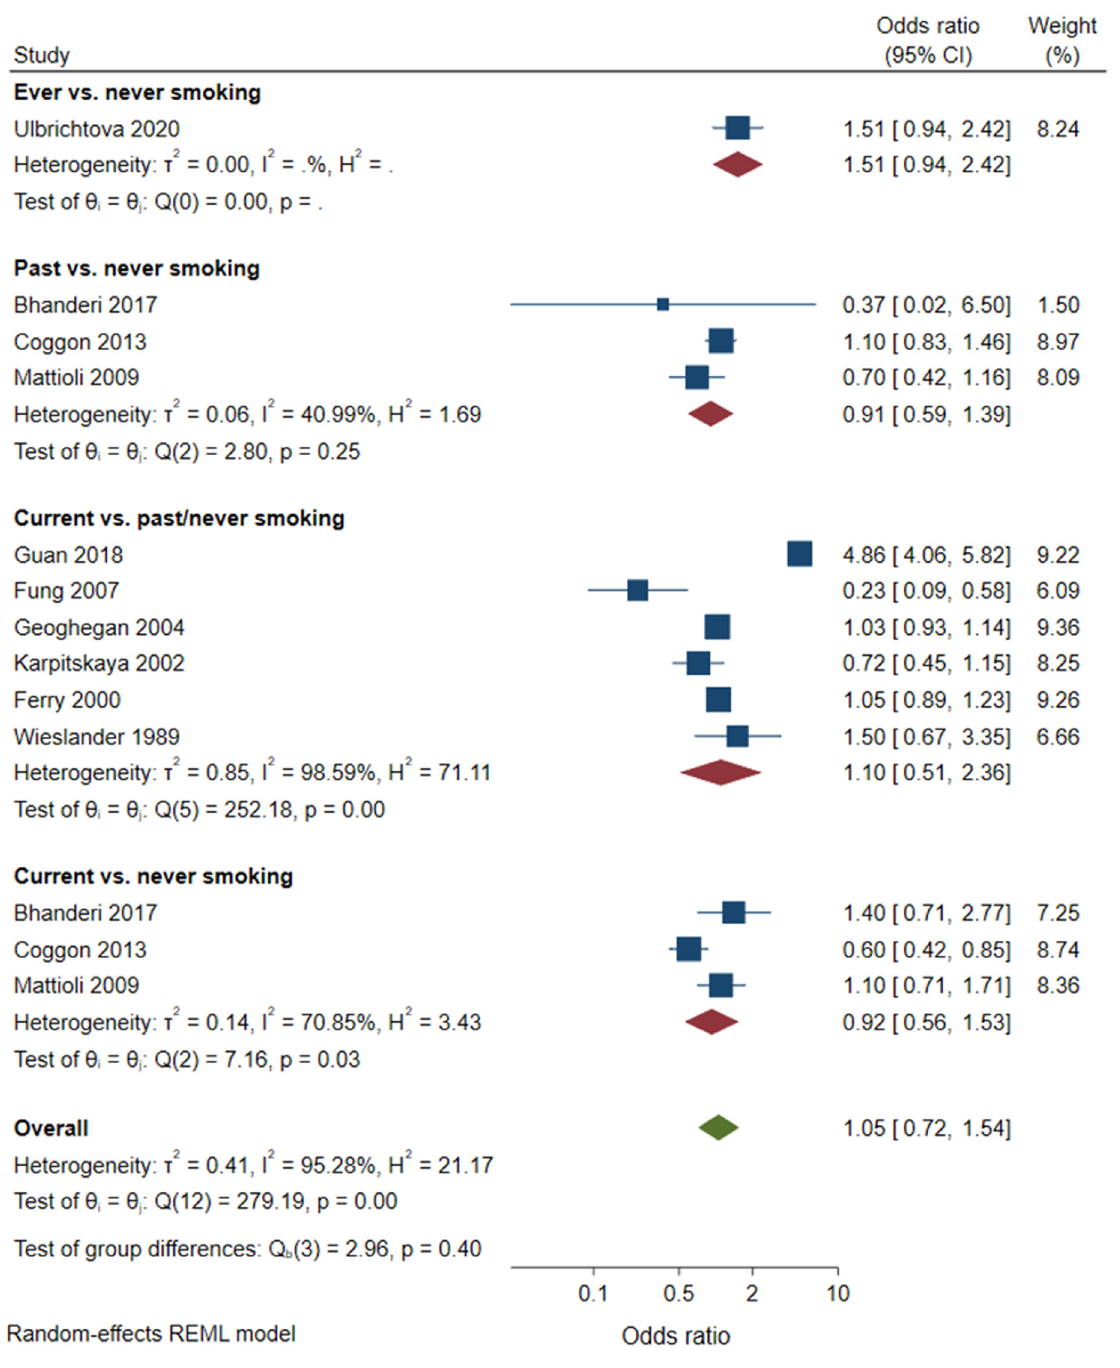
Figure 3. Meta-analysis of case-control studies on smoking and CTS.